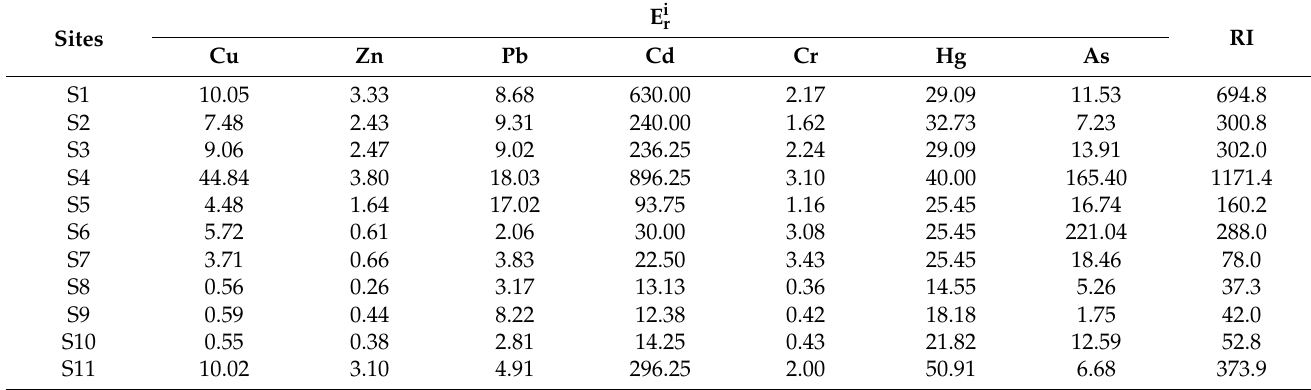
E ) and potential ecological risks (RI) of heavy metals. Table 3. Individual ecological risks ( i r Table 3. Individual ecological risks (E i r ) and potential ecological risks (RI) of heavy